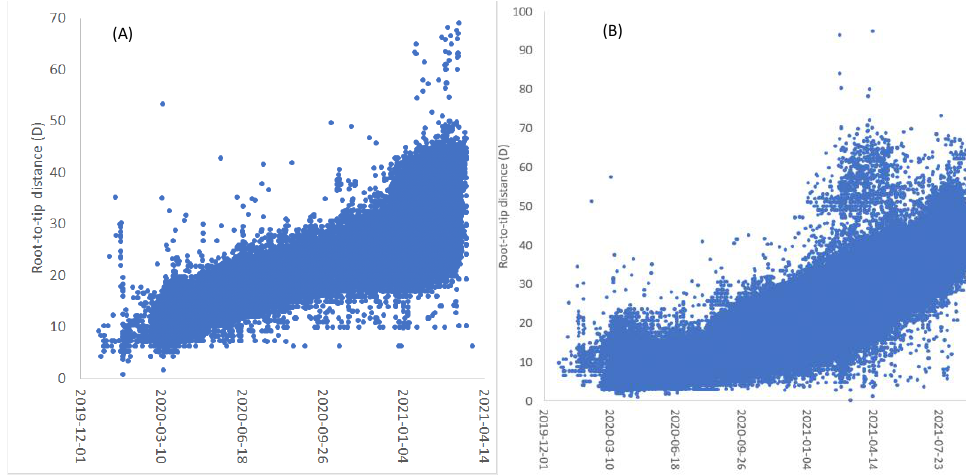
Figure 3. Changes in evolutionary rate over time visualized by plotting root-to-tip distance ( D ) over viral sample collection time (horizontal axis). D is from the optimal root estimated as described. ( A ) Relationship between D and T from the tree released by NCBI on 3 April 2021, and ( B ) on 7 May 2022.